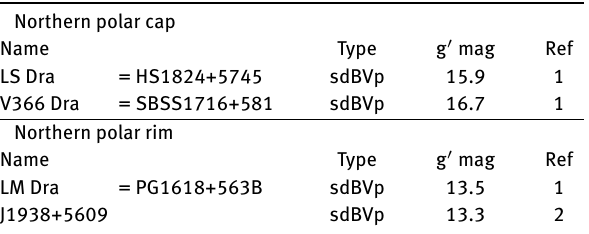
Table 1. Overview of known sdB pulsators in the ecliptic north- ern polar cap and polar rim. Ref 1: Østensen et al. (2010), ref 2: Holdsworth et al.